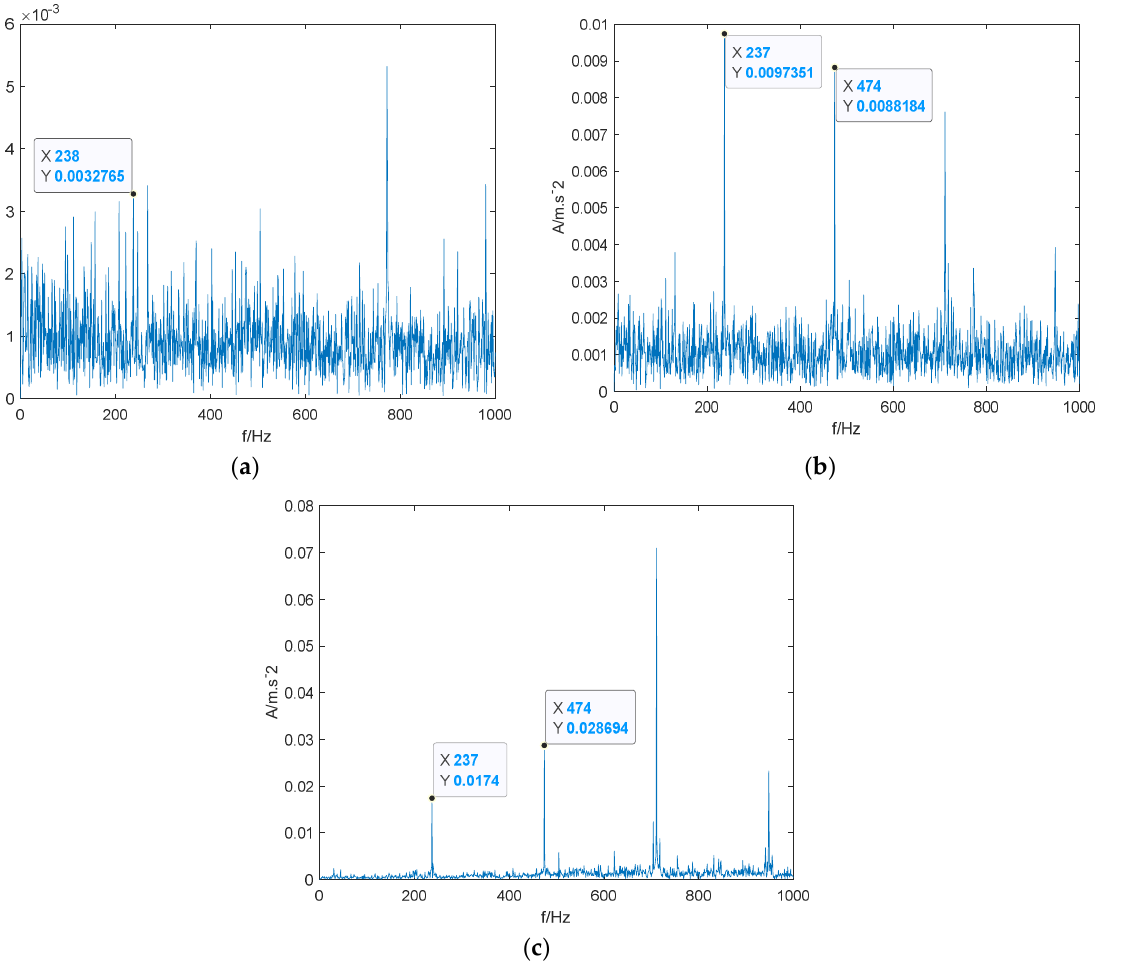
Figure 23. Envelope pectrum of key sampling points in bearing 3; ( a ) 854th data point; ( b ) 872nd data point; ( c ) 902nd data point.